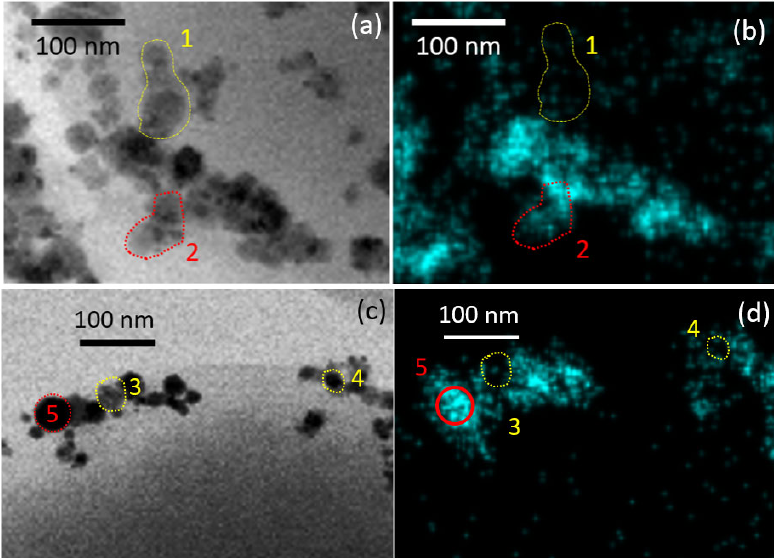
Figure 6. Enlarged TEM images of S. aureus cell after treatment with ( a ) Ag NPs solution; ( c ) treated with AgNO 3 and; and ( b , d ) the corresponding EDS map of Ag content in ( a , c ). Yellow shapes highlight NPs, visible on TEM images but absent in EDS maps. Red shapes highlight NPs visible both in TEM image and EDS maps. See text for details.